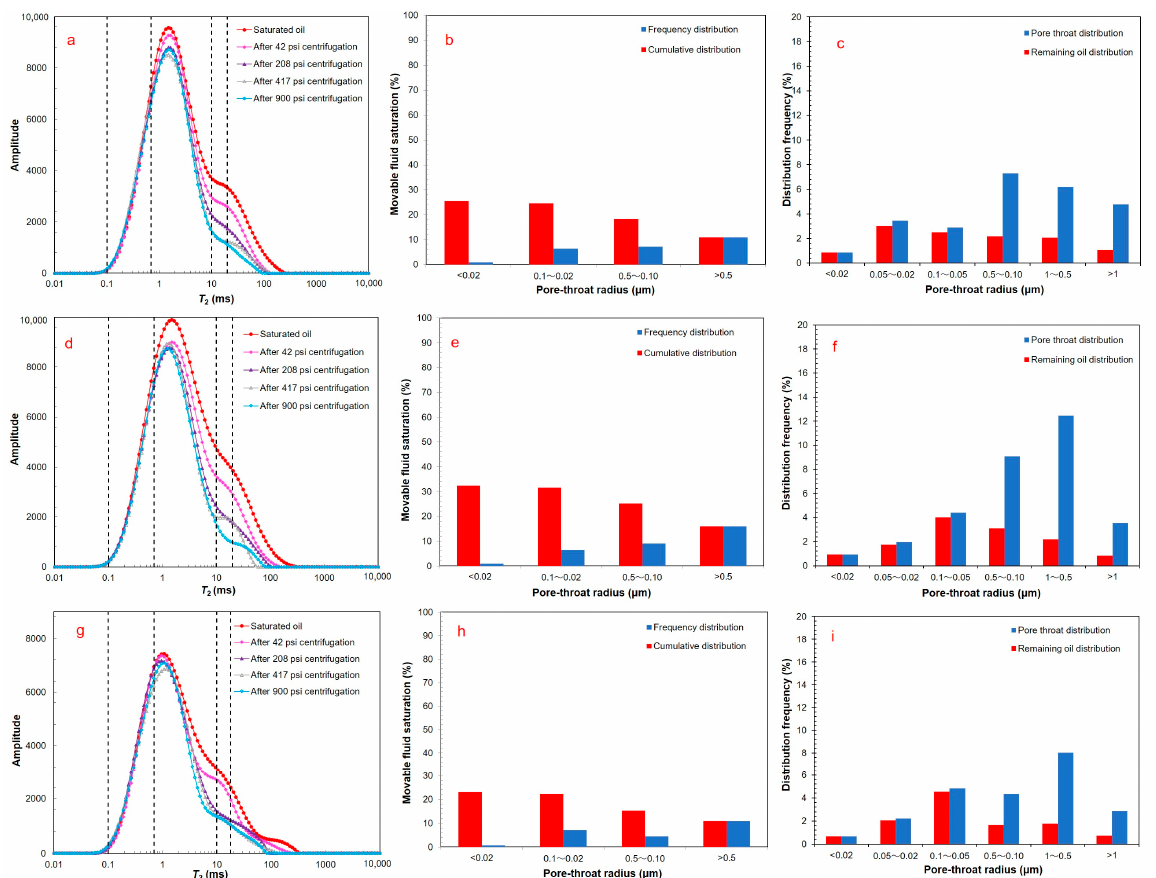
Figure 8. Centrifugal NMR results of core samples of type Ⅲ reservoir; ( a , d , g ) are the T 2 spectrum of centrifugal NMR of CD-1, CD-6 and CD-8, respectively; ( b , e , h ) are the throat radius distribution frequency diagram of CD-1, CD-6 and CD-8, respectively; ( c , f , i ) are the frequency distribution of residual oil in pore space of different scales of CD-1, CD-6 and CD-8, respectively. CD-9 belongs to the type IV reservoir. The T 2 spectrum of the type IV reservoir shows a unimodal distribution in the saturated oil state, indicating the absence of large pore throats. (Figure 9a). The T 2 cutoff values of the effective pore, movable fluid pore and movable crude oil pore are 1.0 ms, 12.0 ms and 20.0 ms, respectively. For the type IV reservoir,